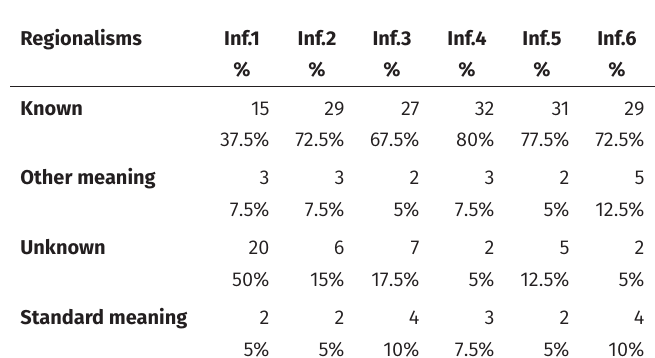
Table 6: Results from Porto Moniz.